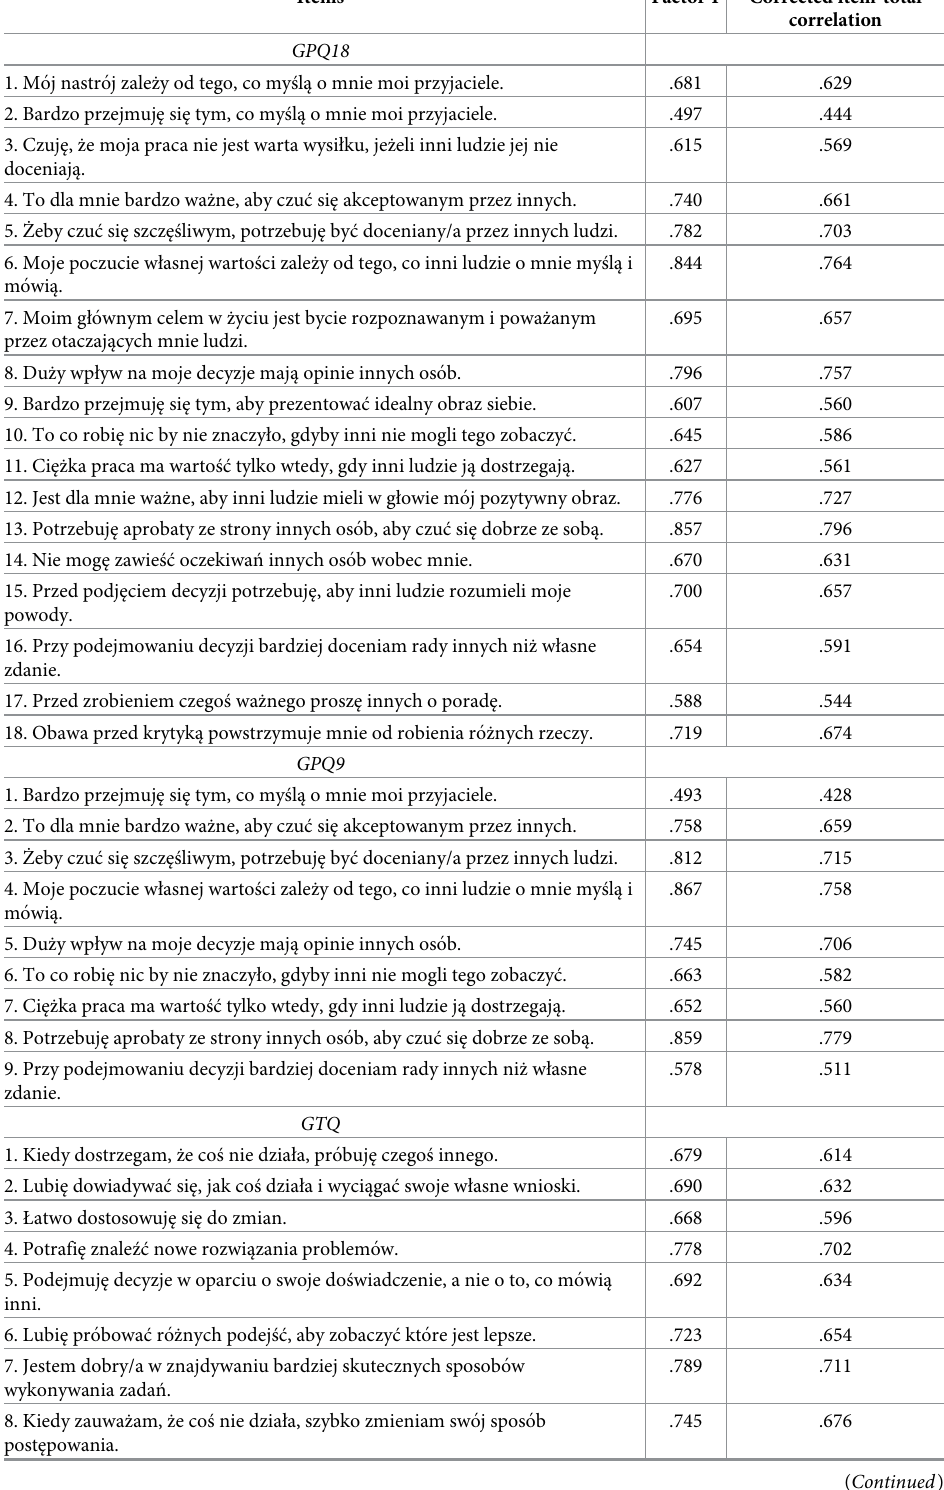
Table 1. The Polish version of GPQ18, GPQ9, GTQ and GSPQ items’ factor loadings and corrected item-total correlations. Items Factor 1 Corrected item-total